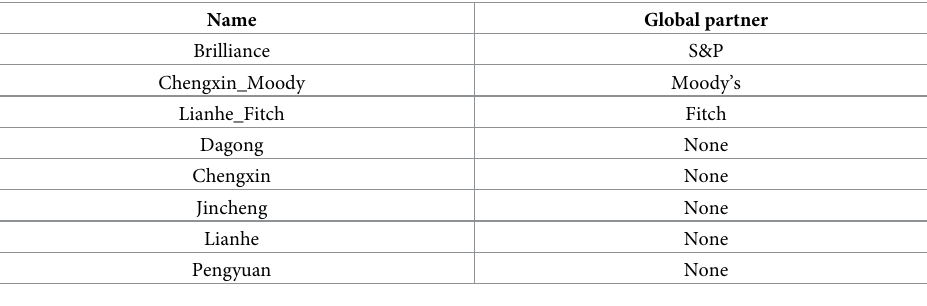
Table 5. List of major Chinese credit rating